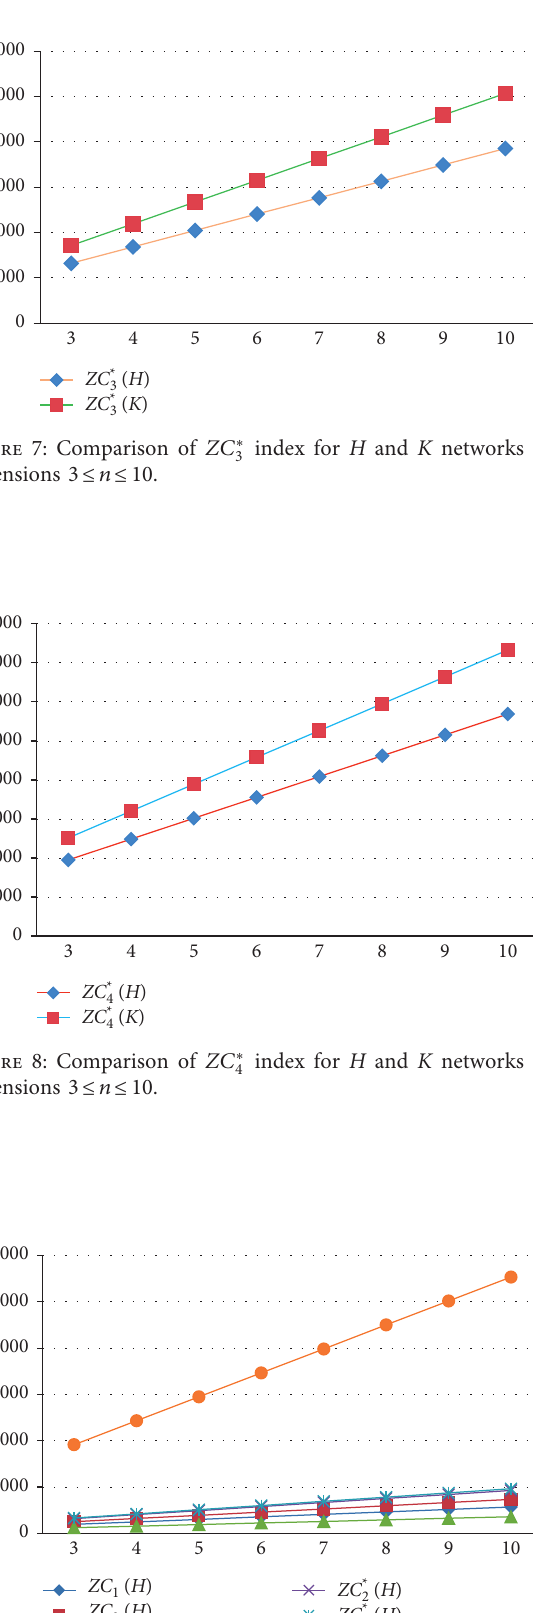
Figure 9: Comparison of ZCIs of network H on dimensions 3 ≤ n ≤